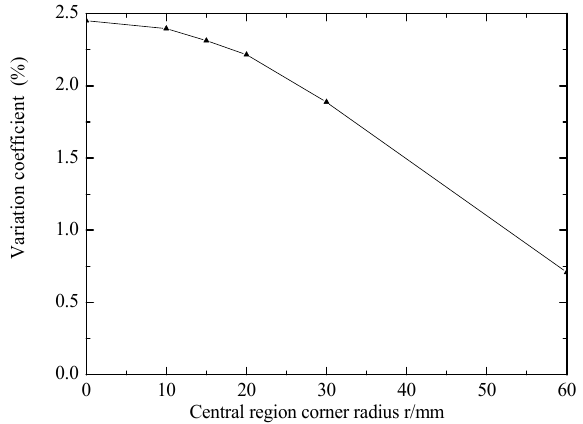
ff ect of central region corner radius on stress in central region. Materials 2019 , 12 , x FOR PEER REVIEW